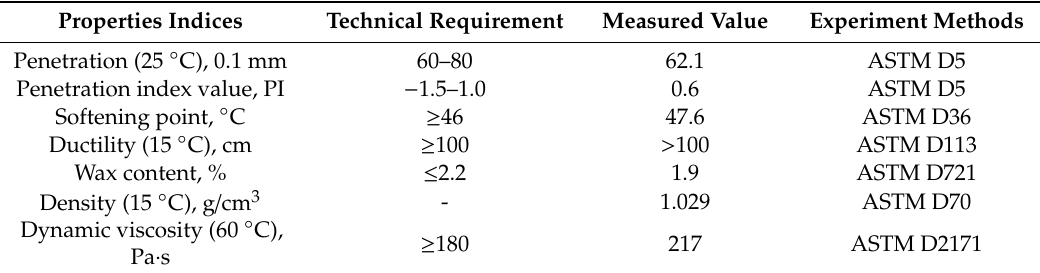
Table 1. Main properties indices of base asphalt.